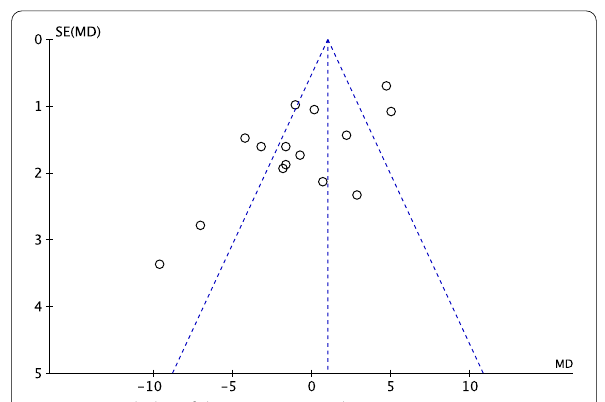
Fig. 3 Funnel plot of the most reported outcome (cup